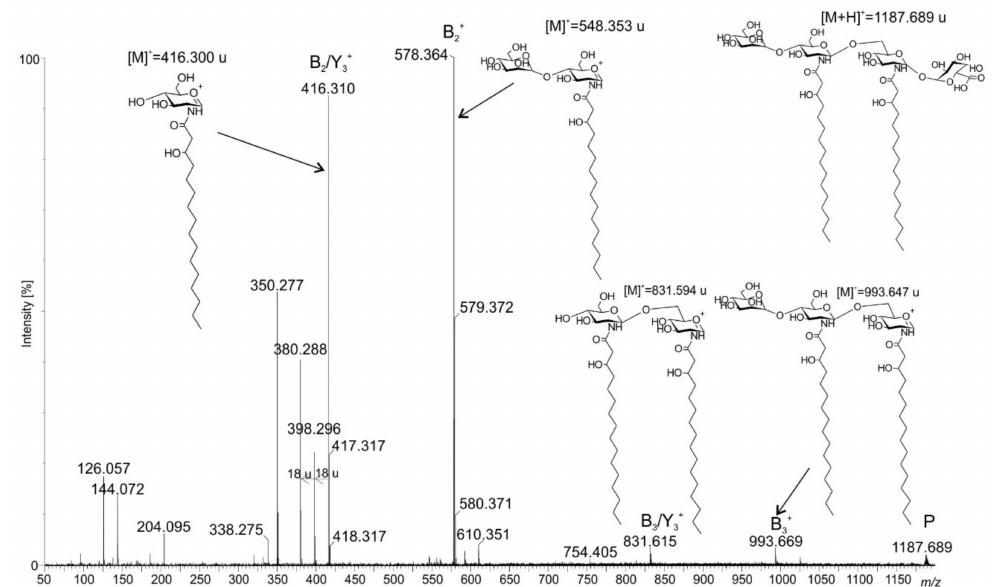
Figure 3. Positive ion ESI-MS-MS spectrum of the signal at m/z